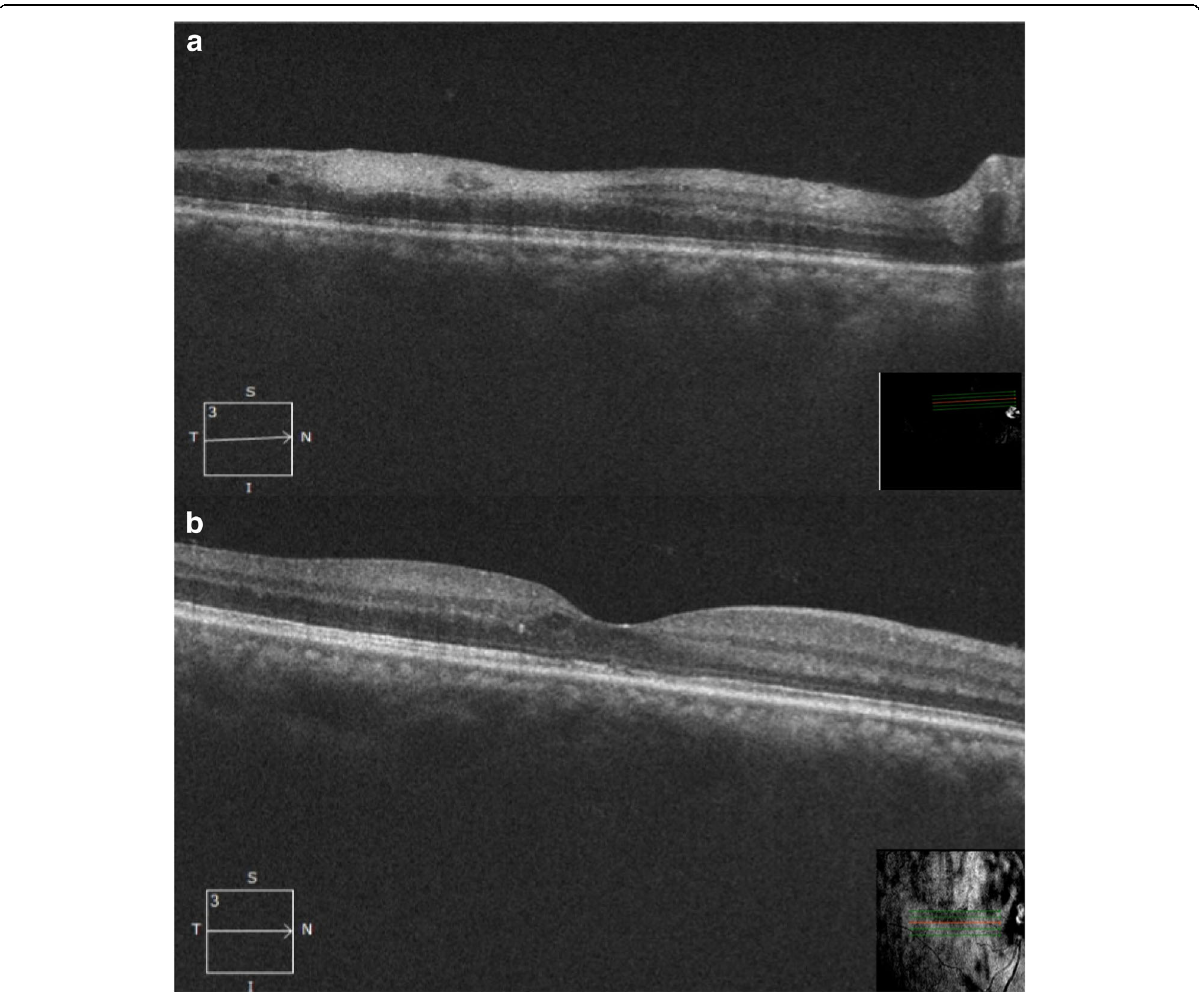
Fig. 4 OCT (at 2 months): raster scan ( a ) through the lesion showing resolving edema and decrease in thickness of the inner retinal layers. b Through fovea showing normal foveal contour with residual discrete cystoid